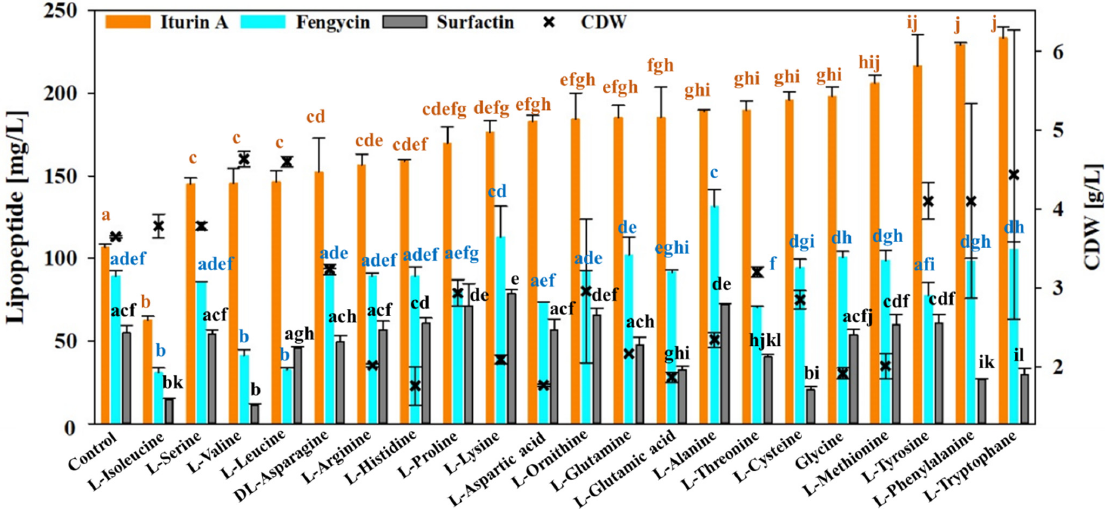
Figure 6. Lipopeptide concentrations and cell dry weight (CDW) achieved in dependence of different amino acid supplements (0.5 mM) by B. velezensis UTB96 after 48 h of cultivation. All tests were performed by On-Way ANOVA based on Holm–Sidak method. Bars with the same superscript letter are not significantly different ( p < 0.05).